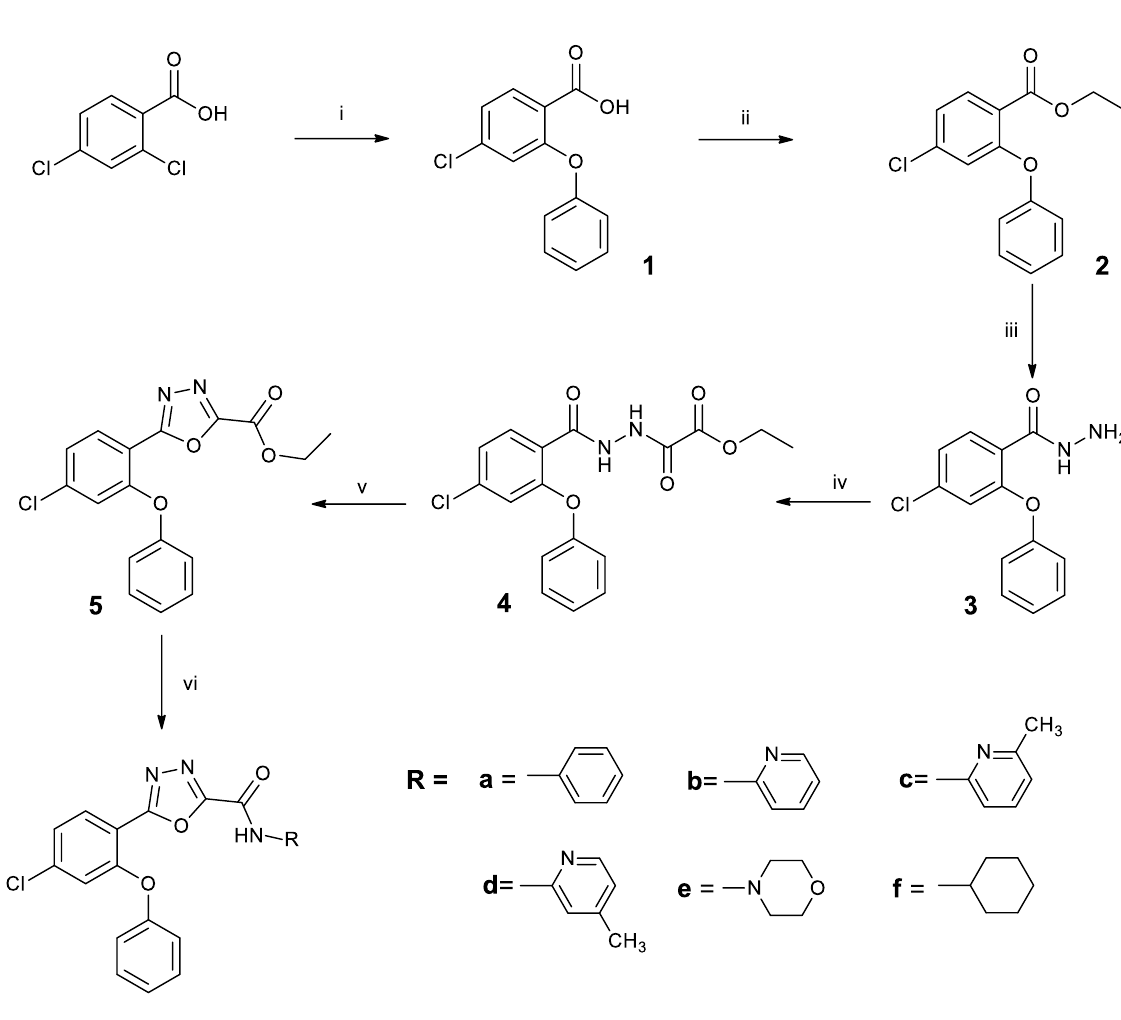
Figure 2: Reagents and conditions: i) phenol, potassium tert-butoxide, Cu, DMF, reflux, 5 h; ii) H 2 SO 4 , EtOH, reflux, 24 h; iii) NH 2 NH 2 .H 2 O, EtOH, rt, 12 h; iv) ethylchloroglyoxylate, triethylamine, THF, 0°C, 3 h; v) P 2 O 5 , toluene, reflux, 3 h; vi) proper amine, AlCl 3 , DCM, rt,